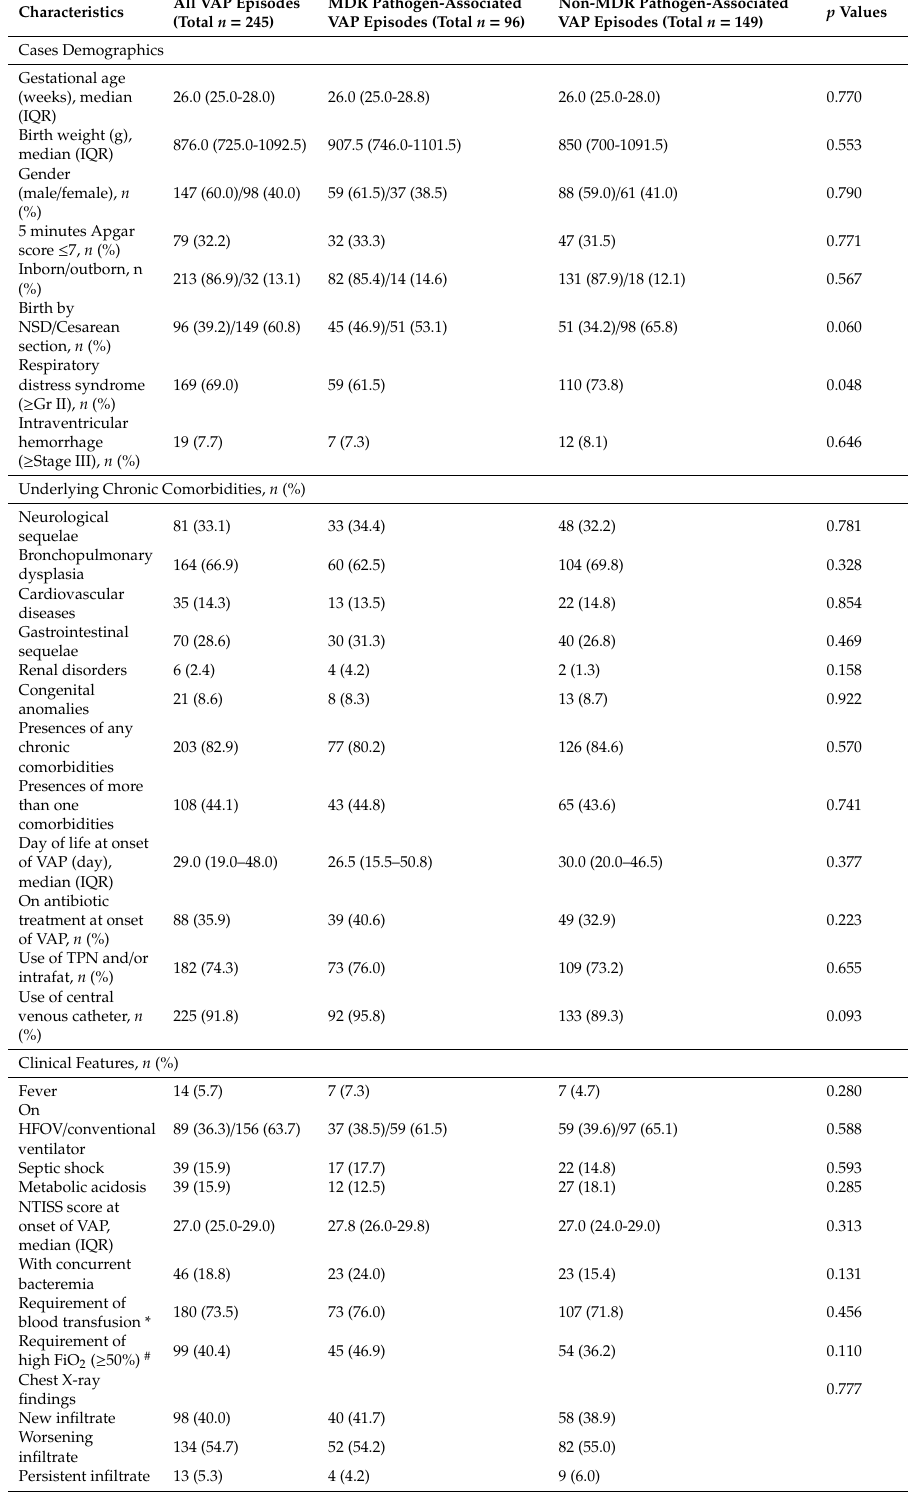
Table 2. Patient demographics, characteristics, and clinical presentation of all neonatal ventilator-associated pneumonia (VAP) at CGMH, October 2017 to March